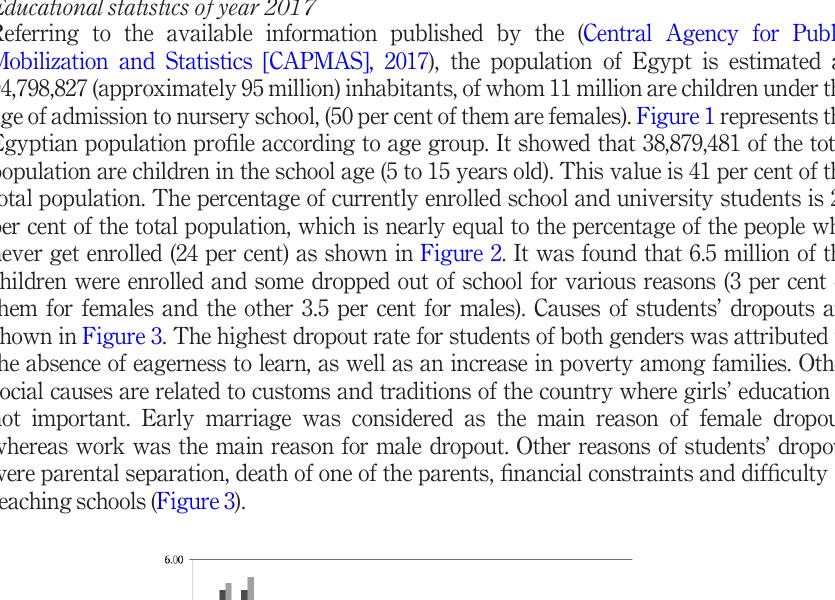
Figure 1. A bar chart showing the Egyptian population pro fi le according to age